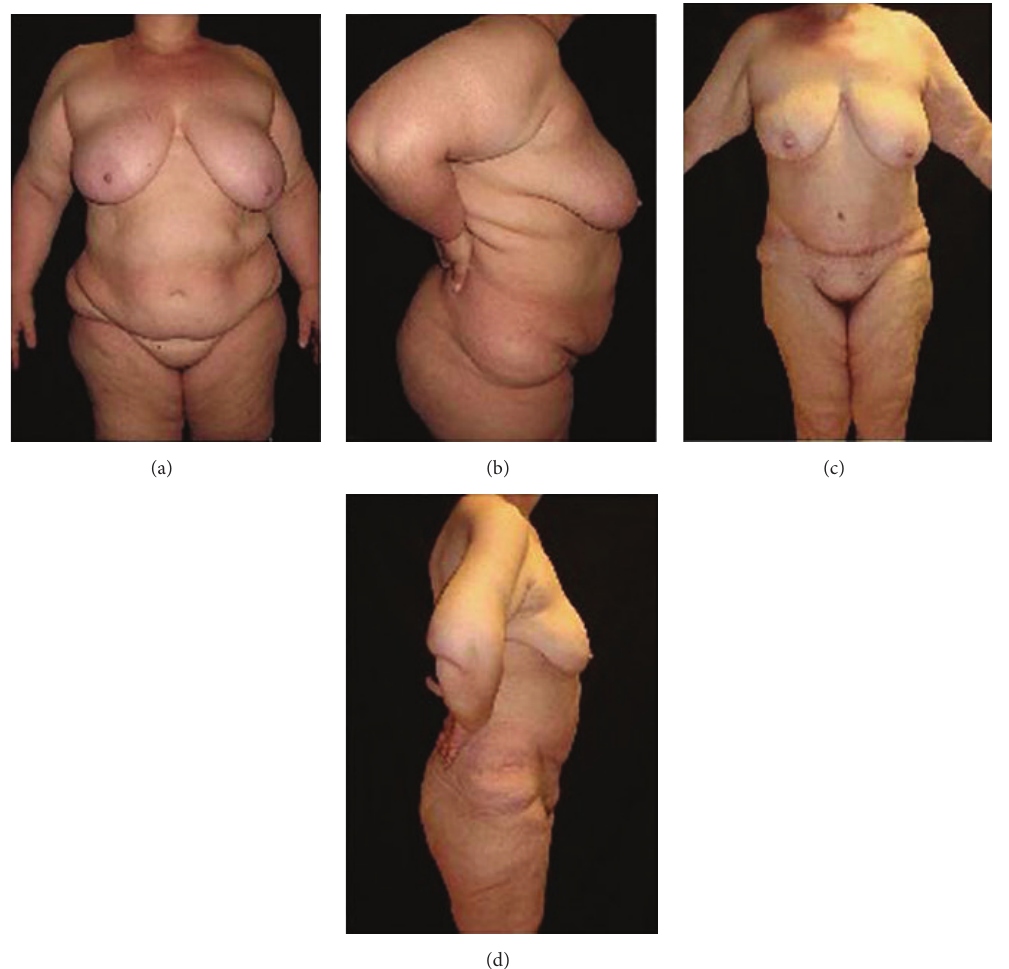
Figure 5: (a) Preoperative frontal view and (b) lateral view of a female patient (BMI = 39 kg/m 2 ; body weight = 106kg). (c) Postoperative frontal view and (d) lateral view 11 months after surgery (body weight = 71kg).